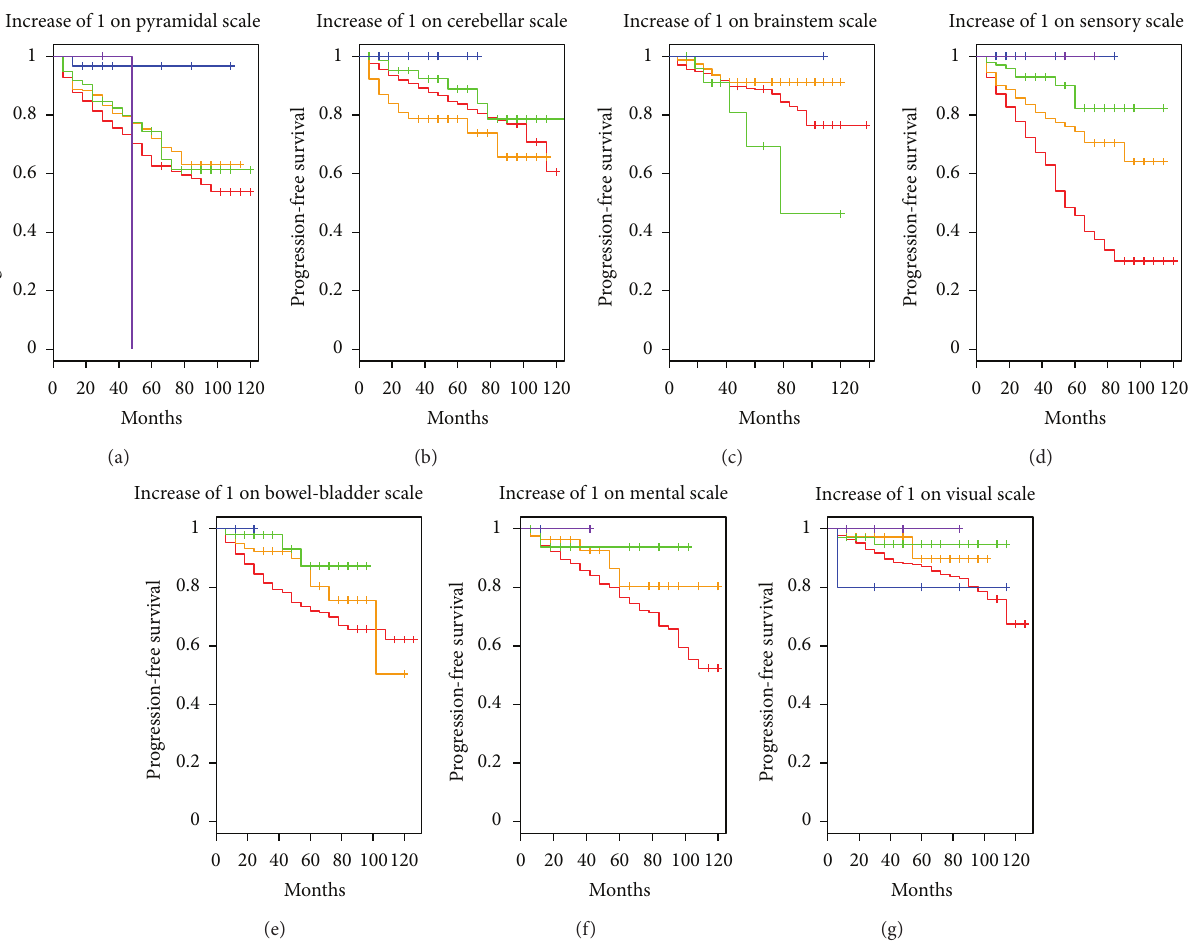
Figure 5: Time to sustained progression stratified by baseline functional system score value. Colors indicate baseline functional system score: score = 0: red, score = 1: orange, score= 2: green, score = 3: blue, score ≥ 4: purple. Progression definition for each plot: top row: D5 to D8; bottom row: D9 to